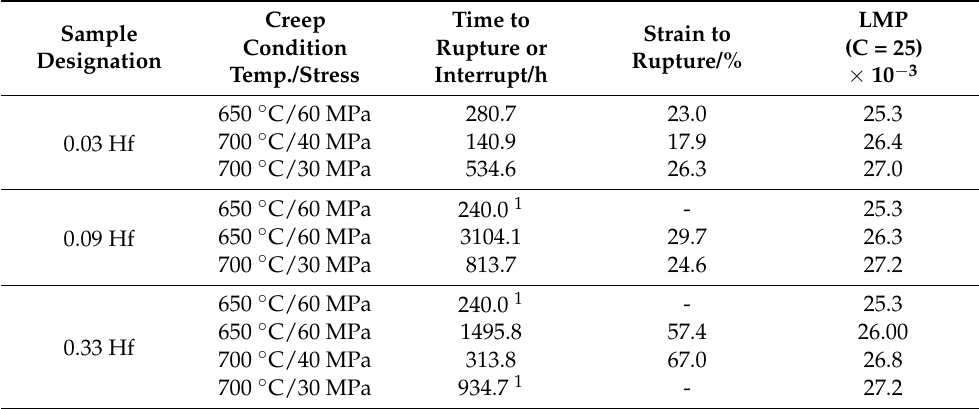
Figure 4. Stress vs. Larson-Miller parameter plot (LMP) for creep rupture time in the alloys tested under the creep conditions indicated. LMP is a parameter to describe the equivalence of time, expressed by T (log t + C) where T is the creep test temperature, t is the time to rupture. C is a constant (25 is taken here). Table 2. Summary of creep data obtained in the present